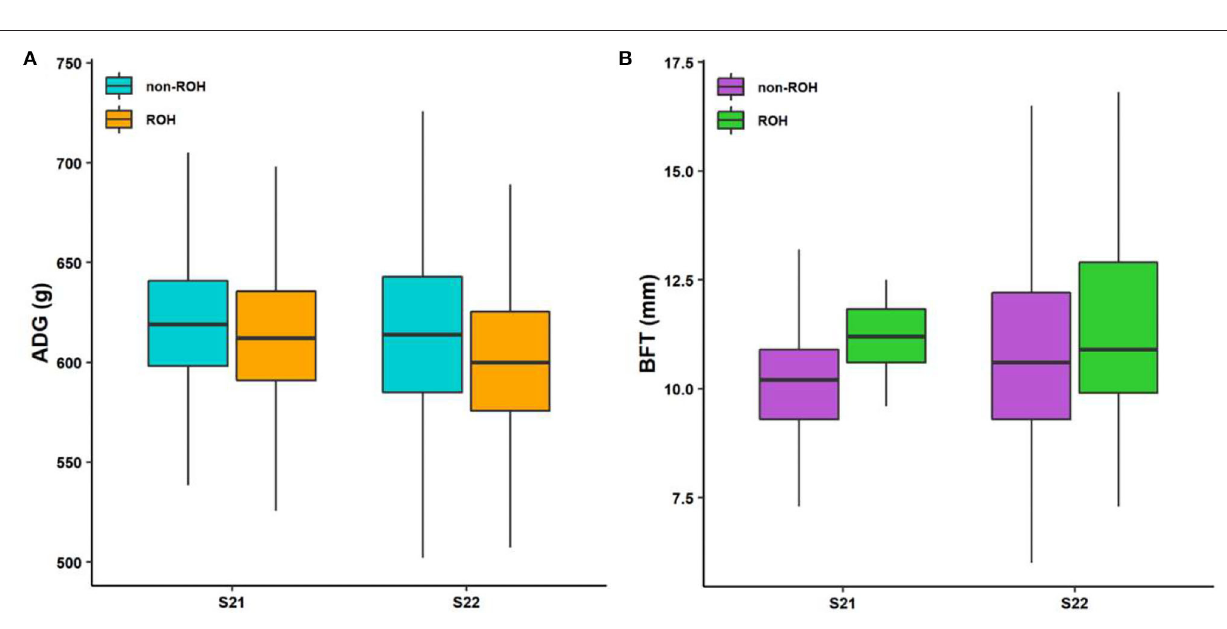
FIGURE 4 | Boxplot of the phenotypic values between individuals with ROH and non-ROH. (A) ROH with adverse effect on ADG. (B) ROH with adverse effect on BFT. S21, Duroc pigs of American origin; S22, Duroc pigs of Canadian origin; ADG, average daily gain at 100kg; and BFT, backfat